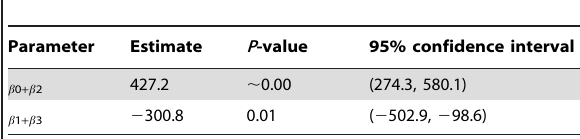
Table 4. Fitting the regression model (7) to the Ae. tauschii